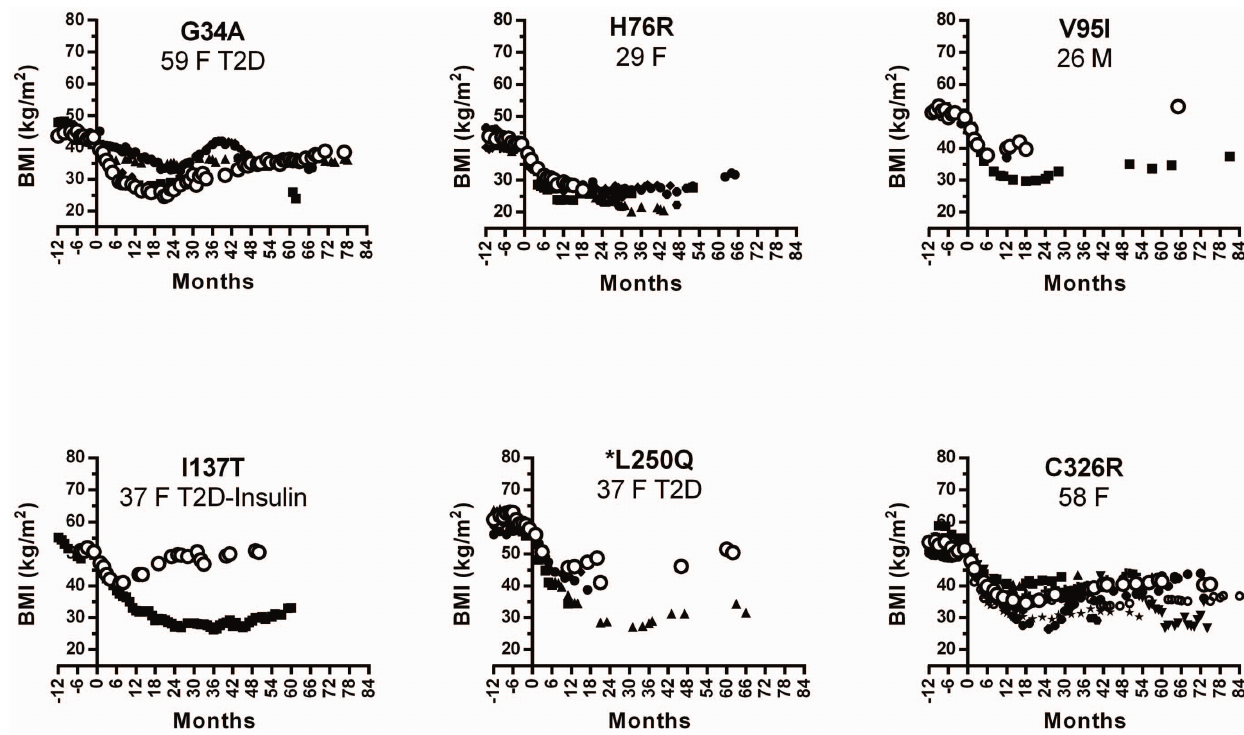
Figure 2. BMIs of patients with rare variants only found in obese populations. The pre-surgery BMIs of patients with rare variants were matched with non-carrier patients of the same gender, T2D status, insulin medication status and similar age (within 5 years) (black symbols). The variant carrier’s age, sex and T2D status is also listed ( # ). *The starting BMI range for the matched patient was extended to 6 2.